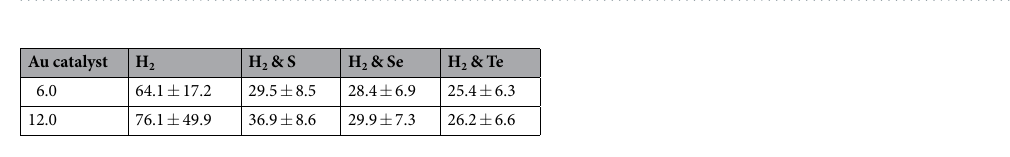
Table 1. Diameter comparison of GaAs NWs prepared by using different chalcogens as in-situ surface passivators (unit: